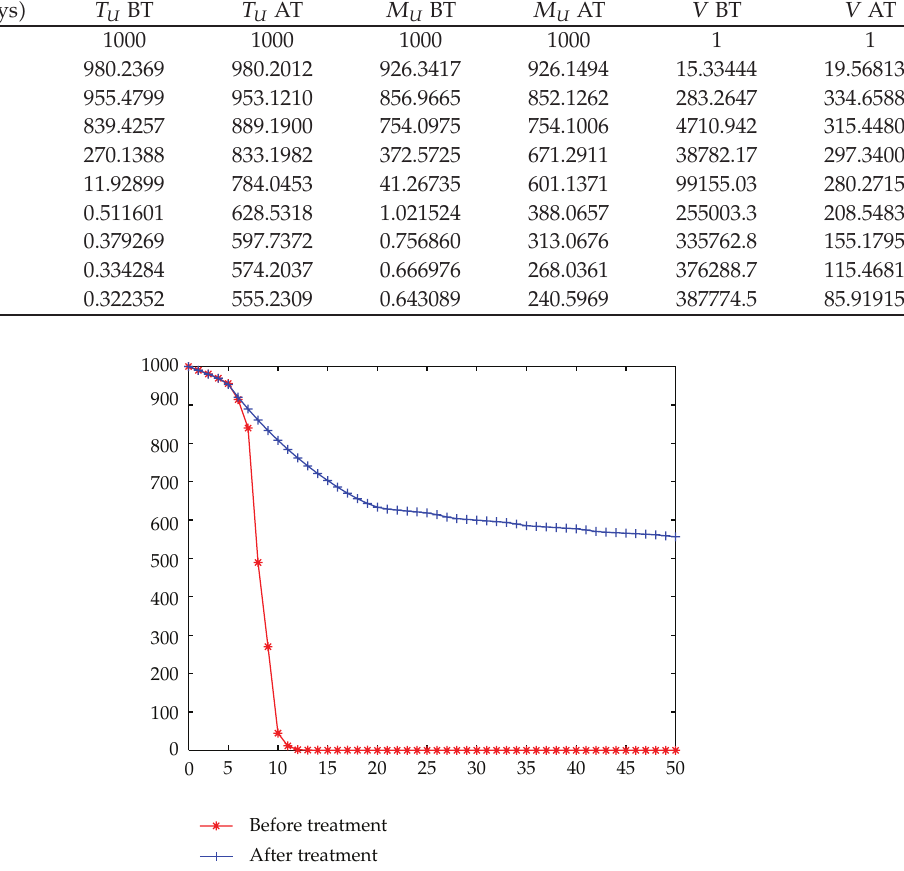
Before treatment After treatment Figure 3: Uninfected T